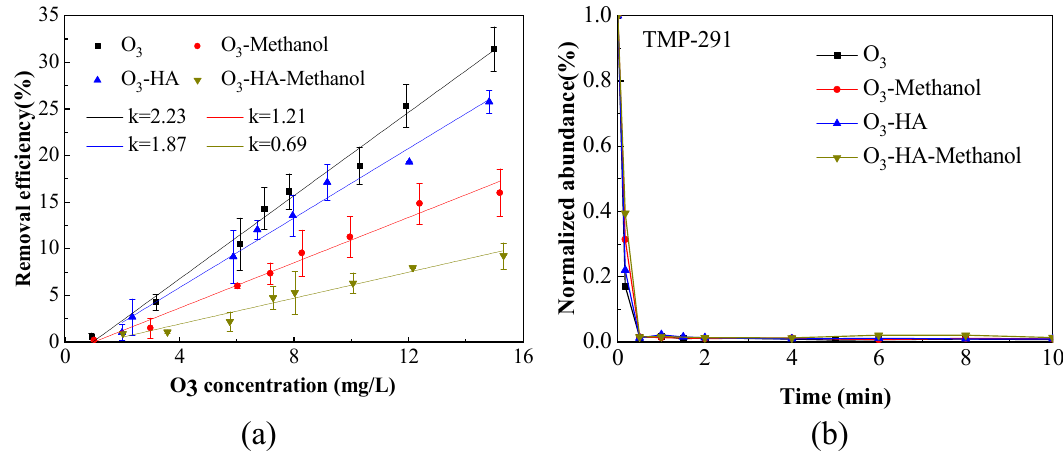
Figure 1. E ff ect of O 3 concentration on Trimethoprim (TMP) removal e ffi ciency ( a ) (initial TMP Figure 1. Effect of O 3 concentration on Trimethoprim (TMP) removal efficiency ( a ) (initial TMP concentration = 10 mg / L, initial pH = 6.0 ± 0.1, 0 ◦ C) and the ozonation rate of TMP in four water concentration = 10 mg/L, initial pH = 6.0 ± 0.1, 0 °C) and the ozonation rate of TMP in four water substrates ( b ) (initial TMP concentration = 10 mg / L, initial pH = 6.0 ± 0.1, 20 ◦ substrates ( b ) (initial TMP concentration = 10 mg/L, initial pH = 6.0 ± 0.1, 20 °C).